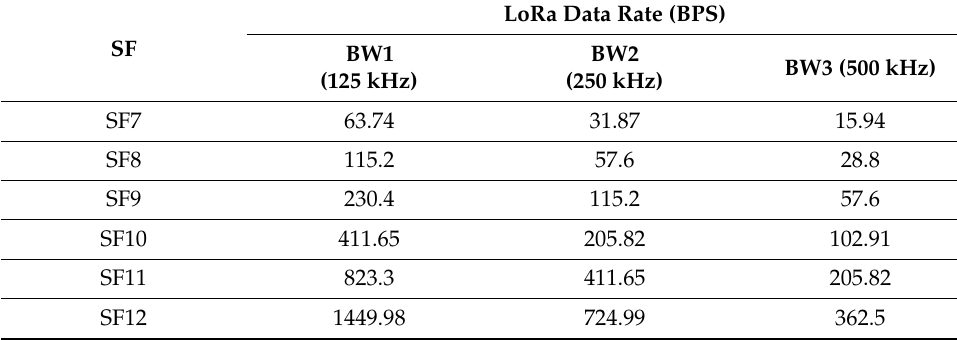
Table 11. Time on air (ToA) (ms) at CR2.